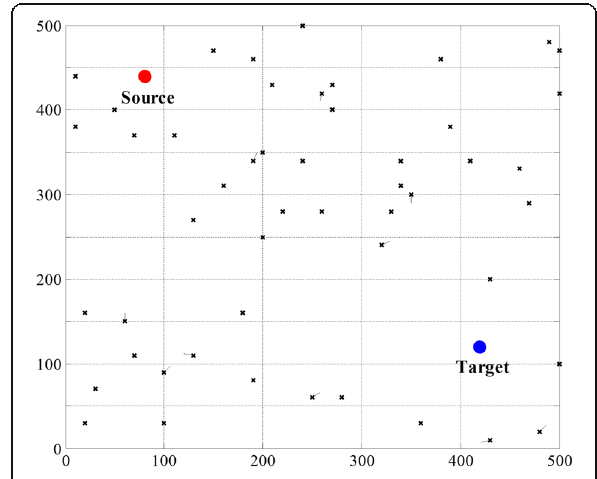
Fig. 5 The initial graph which used to simulate our algorithm, in which sensor types include directional sensor and omnidirectional sensor